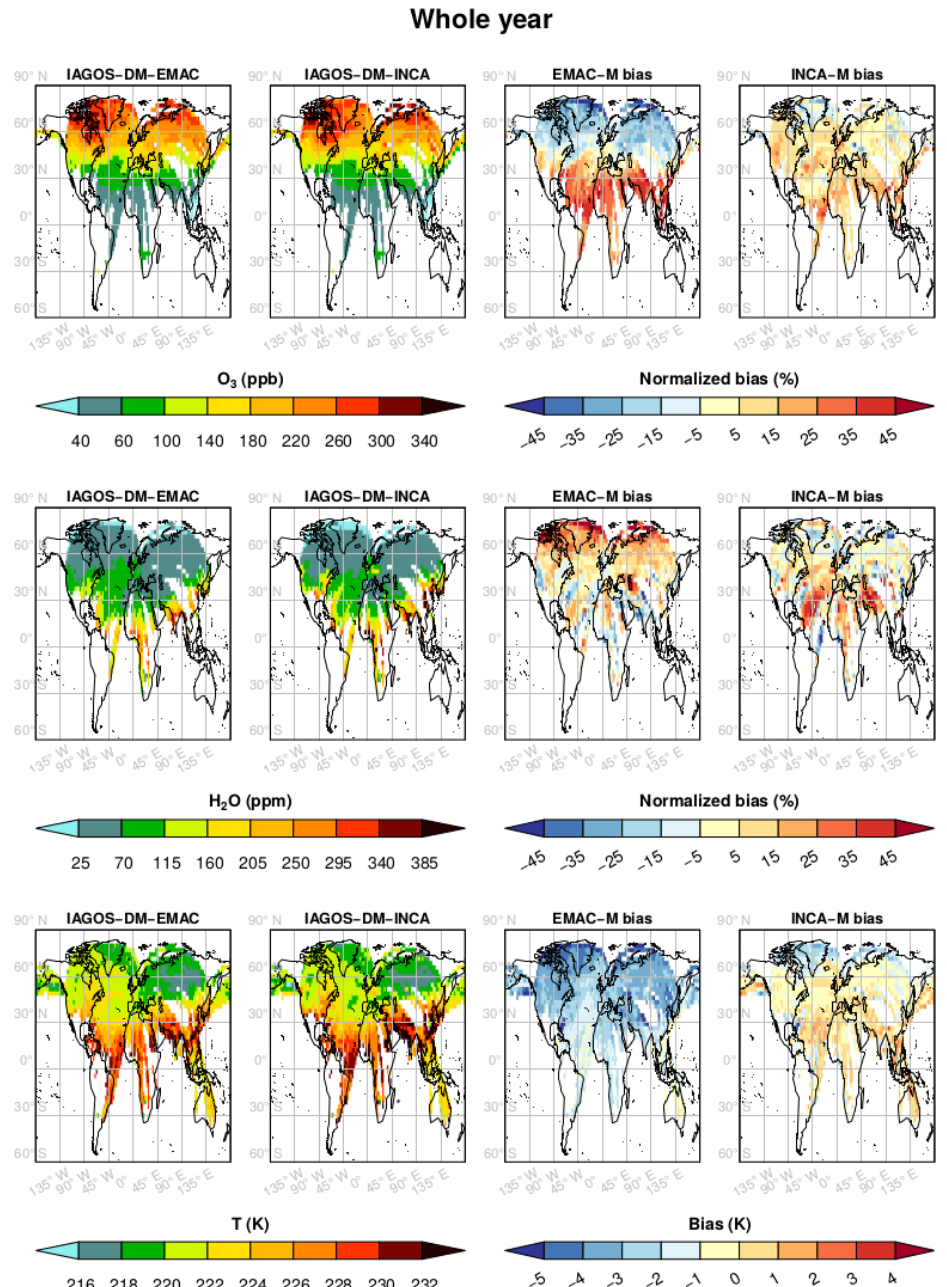
Figure A8. Annual mean climatologies for ozone, water vapor, and temperature (from top to bottom) averaged over 2000–2014 and vertically through the cruise levels. The first and second columns represent the climatologies seen by the IAGOS observations, projected onto the EMAC grid and onto the INCA grid, respectively, the latter being interpolated onto the EMAC grid afterward. The third and fourth columns show the biases between the reference simulation for each model and its corresponding gridded IAGOS product. For each grid cell, the normalized bias for the mixing ratios is calculated relatively to the average between observations and the model